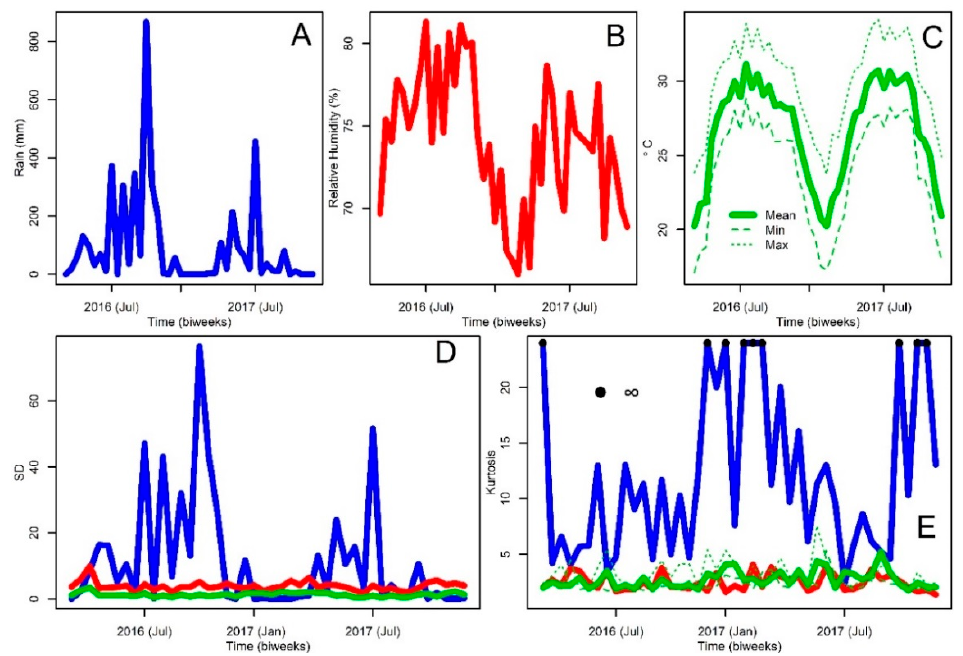
Figure 2. Weather Time series data at Kaohsiung, Taiwan. ( A ) Rainfall in mm; ( B ) Relative humidity, %; ( C ) Temperature including Maximum (Max), Minimum (Min), and Average (Mean), see inset legend for details about the lines. ( D ) Standard deviation, SD, of the environmental variables, lines are color coded according to panels A, B, and C. ( E ) Kurtosis of the environmental variables, lines are color coded according to panels A, B, and C, for rainfall kurtosis black dots indicate infinite values, a perfect leptokurtic distribution estimated during periods without rainfall.